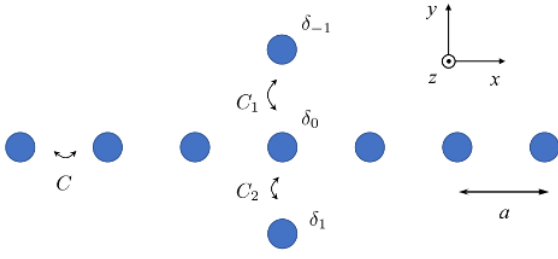
Figure 1. A coupled-waveguide system consisting of a 1D array and two additional waveguides above and below the